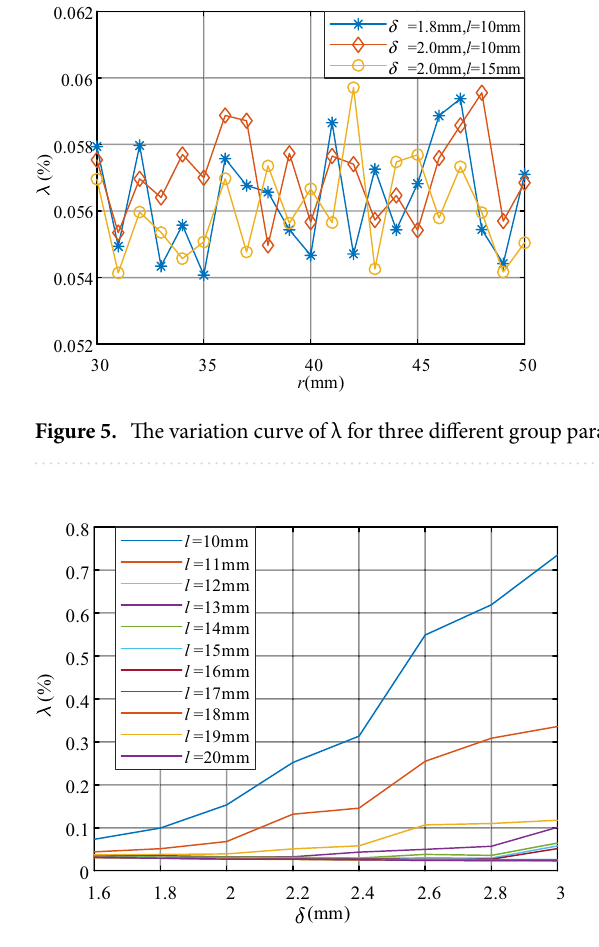
Figure 6. The variation curve of λ for different δ and l